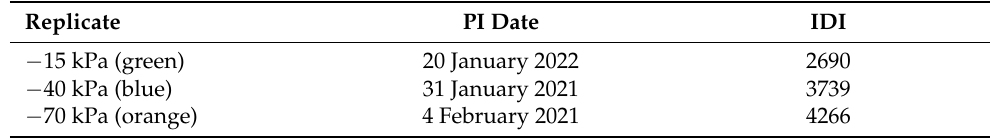
Figure 2. ( A ) Daily ETo (mm) shown as black dots and rainfall (mm) as blue bars from pre-emergent irrigation until PI. ( B ) Cumulative ETo with rainfall subtracted (mm) between irrigation events for three individual replicates ( − 15 kPa—green, − 40 kPa—blue, − 70 kPa—orange) from pre-emergent irrigation until panicle initiation, which is illustrated by dots. Note that the green and blue lines show similar cumulative ETo during the first three deficit events. The deficit integral of each replicate was calculated as per Equation (1). Table 1. Panicle initiation date and irrigation deficit integral (IDI) of corresponding replicates presented in Figure